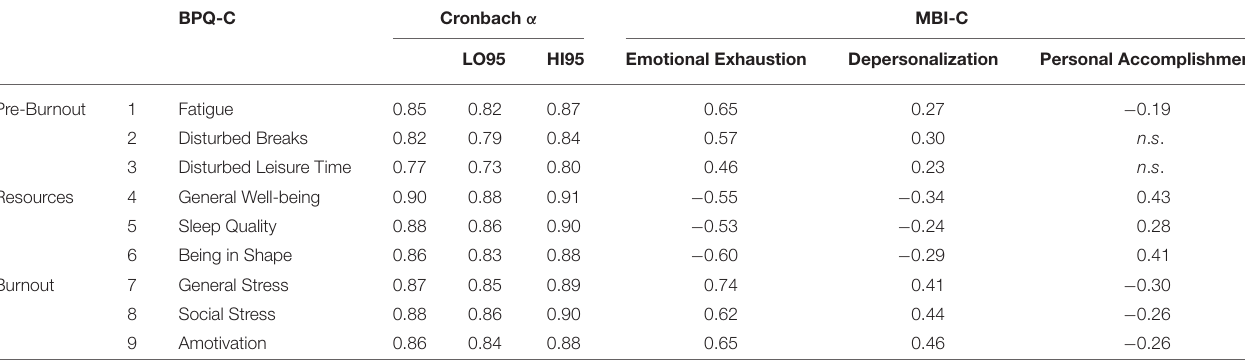
LOWER DATA MATRIX: STUDY 2 r ≥ 0.70 are printed in bold type. TABLE 9 | Correlation between BPQ-C and MBI-C for the sample of study